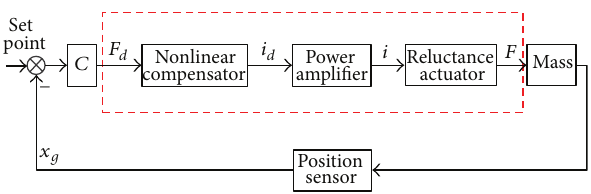
Figure 4: Typical current-driven reluctance actuator control